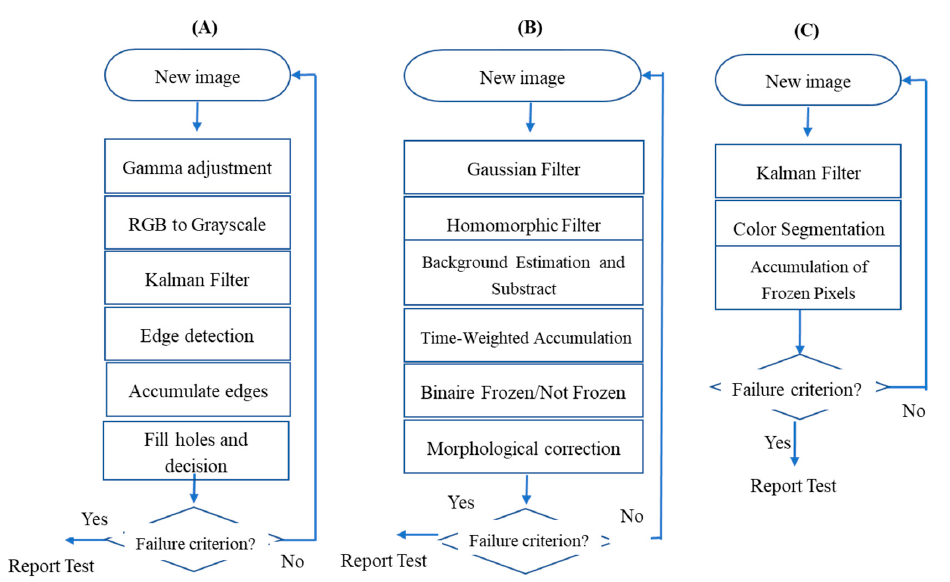
Figure 2. Flowcharts of the algorithms developed: ( A ) WSET, ( B ) LZR, and ( C ) indoor snow test (SNW).